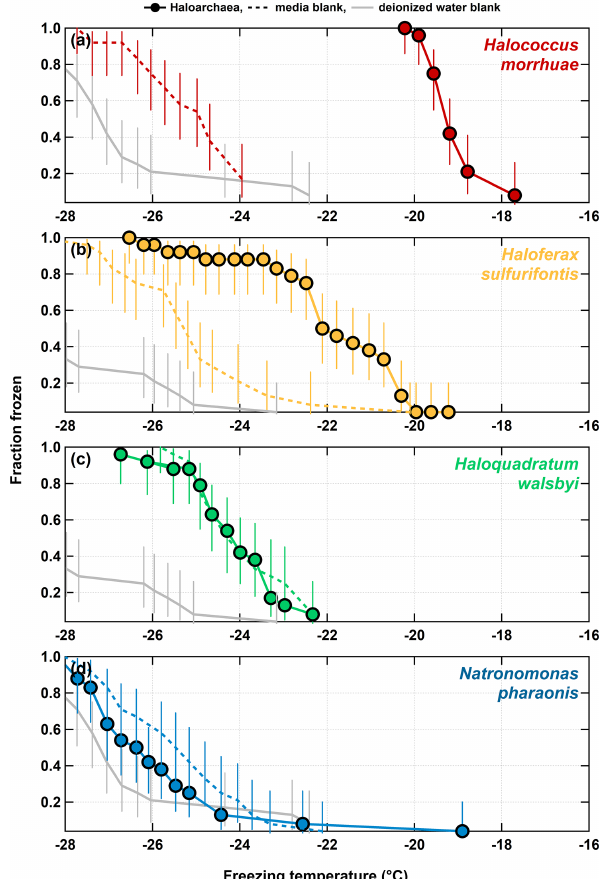
Figure 1. Freezing spectra for each of the haloarchaeal species di- luted 1 : 15 in deionized water. (a) H. morrhuae , (b) H. sulfurifontis , (c) H. walsbyi , and (d) N. pharaonis . H. morrhuae and H. sulfu- rifontis did not lyse, H. walsbyi lysed, and N. pharaonis partially lysed. Note that H. walsbyi and N. pharaonis do not reach a frozen fraction of 1 because not all drops were frozen at the lower limit of the IS tests. Error bars indicate 95% confidence